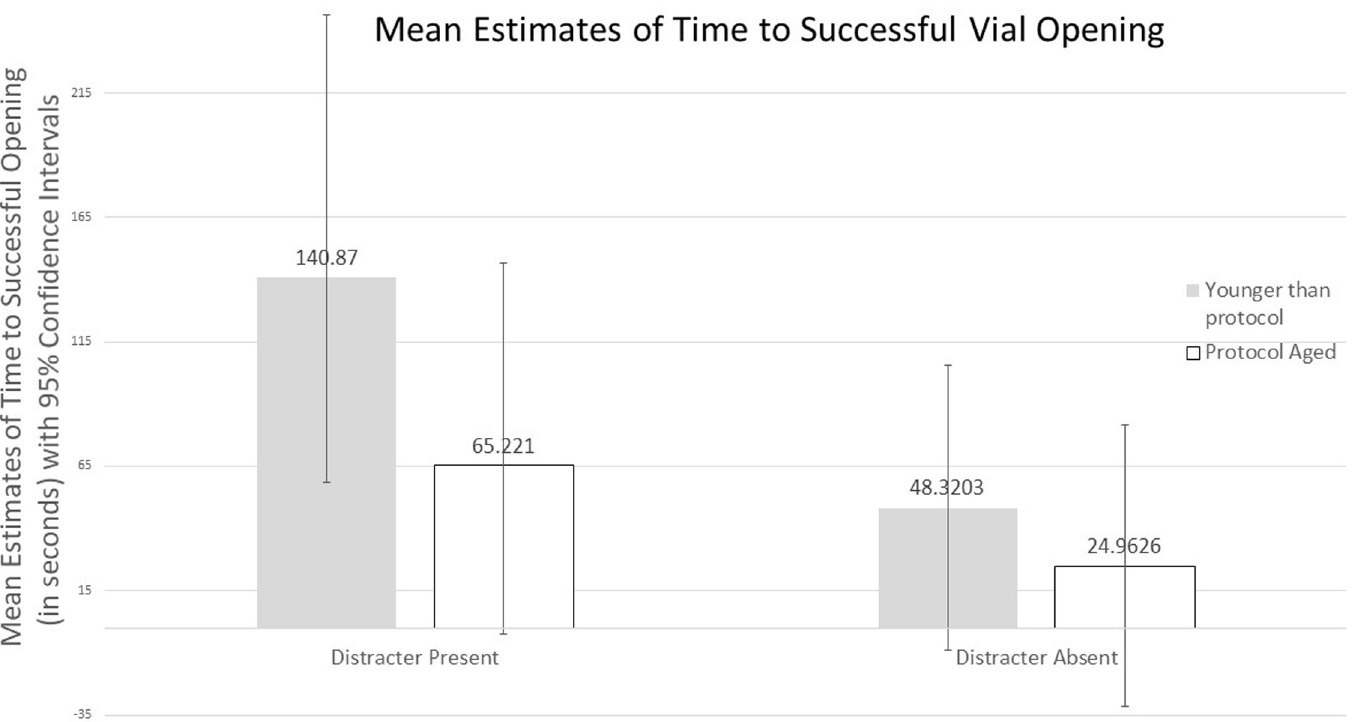
Fig 3. Estimated mean time to opening for successful openings by age group (and corresponding 95% confidence interval) for vials with or without visual